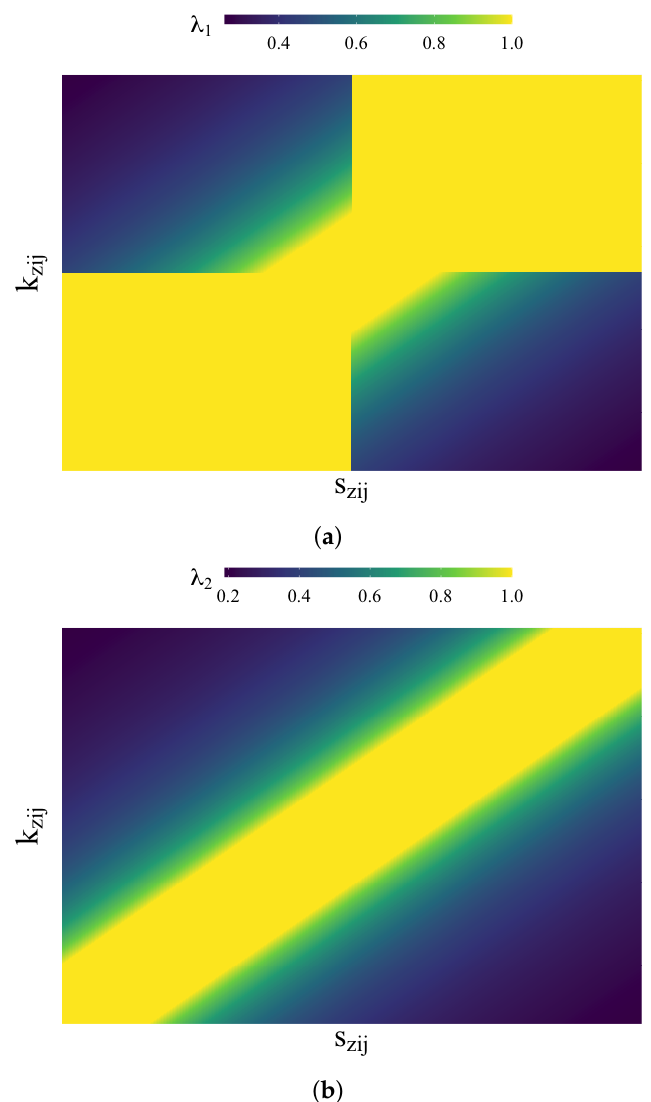
Figure 1. Heat maps for the λ functions. ( a ) Heatmap of λ 1 . ( b ) Heatmap of λ 2